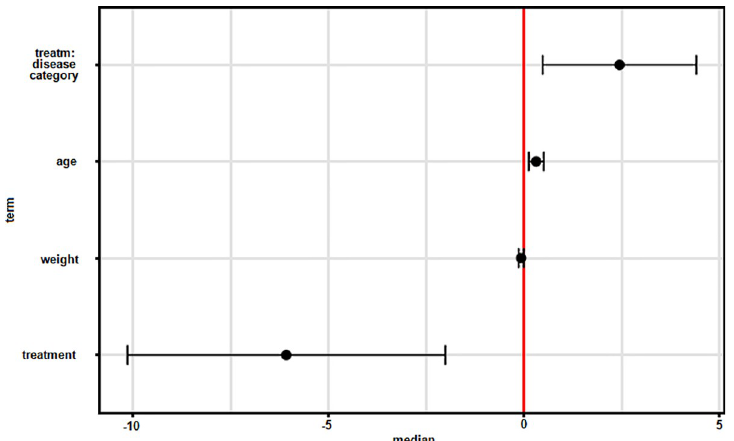
Fig 4. Effect of selected variables on variance of the phospholipid profile on PC2 in plasma. Fixed effects are plotted with 95% confidence intervals. The interaction between treatment and disease category, age, body weight, and treatment do not overlap with 0 and thus significantly affect the variance of the phospholipid composition (ANOVA p < 0.05). treatm:disease category, interaction of treatment and disease category.